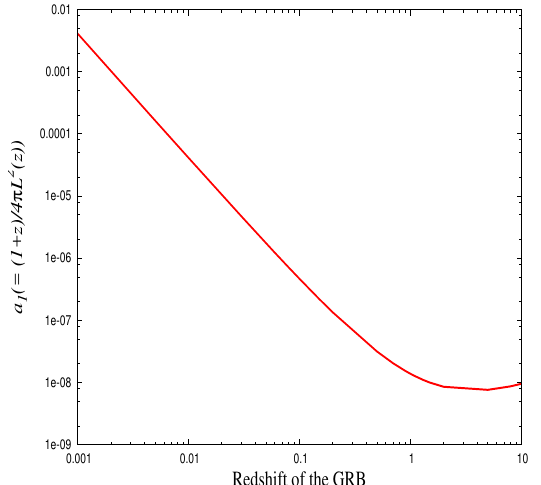
Figure 3 . Variations of the factor a 1 (= 1 for